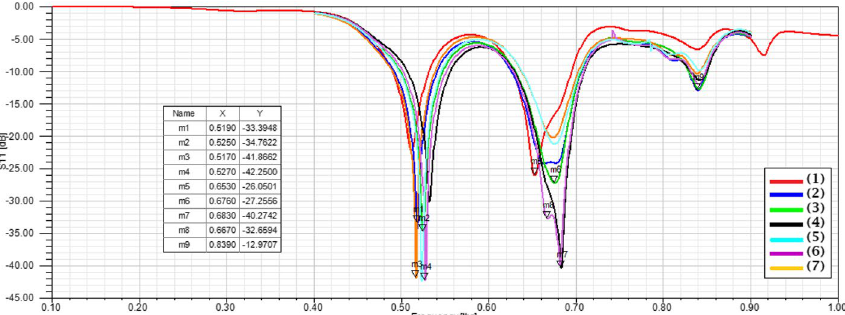
Fig. 14 Simulated reflection coefficient of microstrip patch antenna loaded with periodic arrays